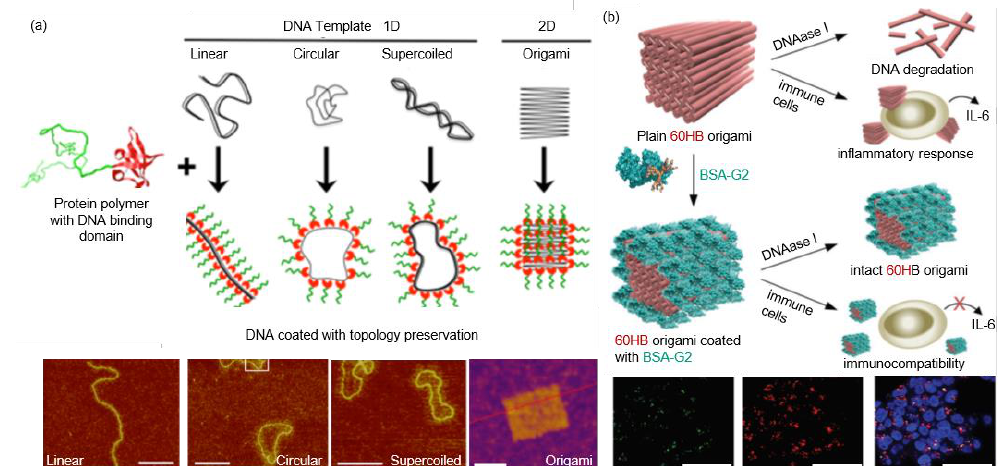
Figure 7. DNA nanostructures coated with proteins through electrostatic interactions. ( a ) Top panel: Schematic representation of DNA nanostructures coated with protein polymers. Bottom panel: Corresponding AFM images of DNA nanostructures coated with protein polymer. Scale bar: 50 nm. Reprinted with permission from [114]. Copyright (2017) American Chemical Society. ( b ) Top panel: Schematic illustration of the 60HB origami coated with BSA-G2 and the subsequent shielding effect against DNAase. Bottom panel: Confocal images of HEK293 cells after transfection with BSA-G2-coated 60HB for 12 h. The left panel is the green AlexaFluor 488 of origami channel, the middle panel is red LysoTracker, and the right panel contains the overlap of the left and middle panel and DAPI-stained nuclei. Scale bar: 50 μm. Reproduced with permission from [118].